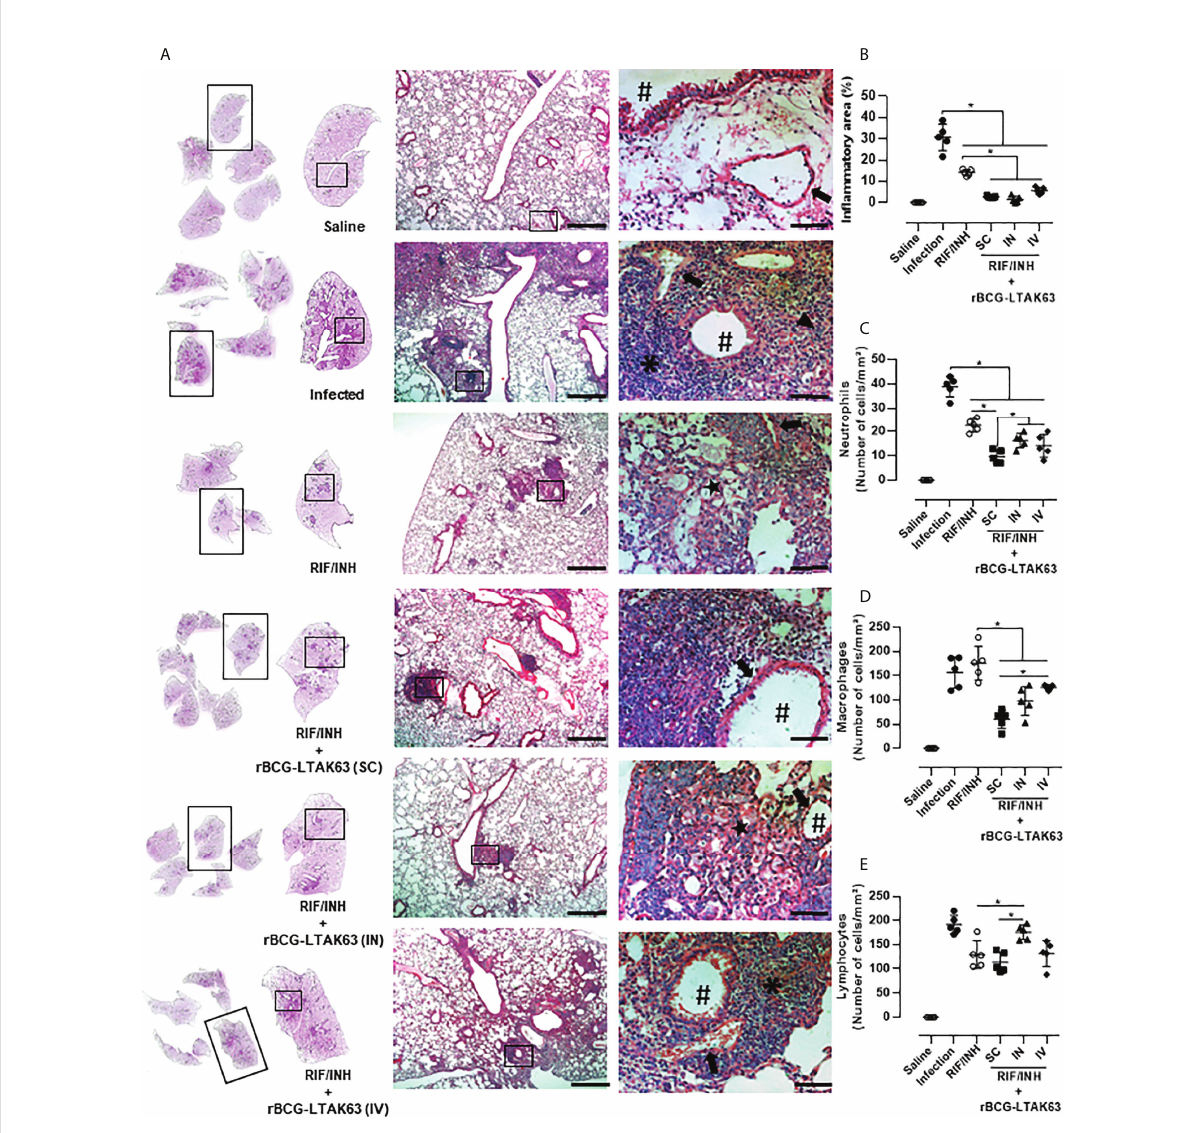
FIGURE 6 Histopathological analysis of the lungs of mice treated with combination antibiotics (RIF/INH) and rBCG-LTAK63 by different inoculation routes. (A) Representative histopathology of lungs from naïve mice (Saline), infected with Mtb and not treated (Infection), treated with antibiotics for 2 weeks (RIF/INH) or treated with combination antibiotics and rBCG-LTAK63 delivered subcutaneously (SC), intranasally (IN) or intravenously (IV) at 1x, 5x and 20x magni fi cation. Representative images at 40x magni fi cation show the difference in in fl ammatory process between treatments, neutrophilic in fi ltrate (arrowhead), interalveolar macrophage (star) and lymphocyte (asterisk), arteriole (arrow) and bronchioles (hashtag). (B) Lung in fl ammation scores are presented as the mean percentage of in fl ammation area (mm²) for each mouse (n=5/group). The cellular in fi ltrate in the lung sections was classi fi ed in neutrophils (C) , macrophages (D) and lymphocytes (E) and presented as cell counts per mm². Lung sections were stained with H&E (bar, 200 μm (5x) and/20 μm (20x). Statistical differences were determined by one-way ANOVA with a Bonferroni test. *p <